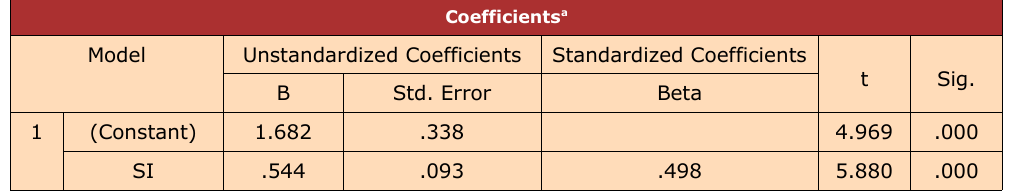
Table 5. Regression Analysis of the dimensions of SI and OCB